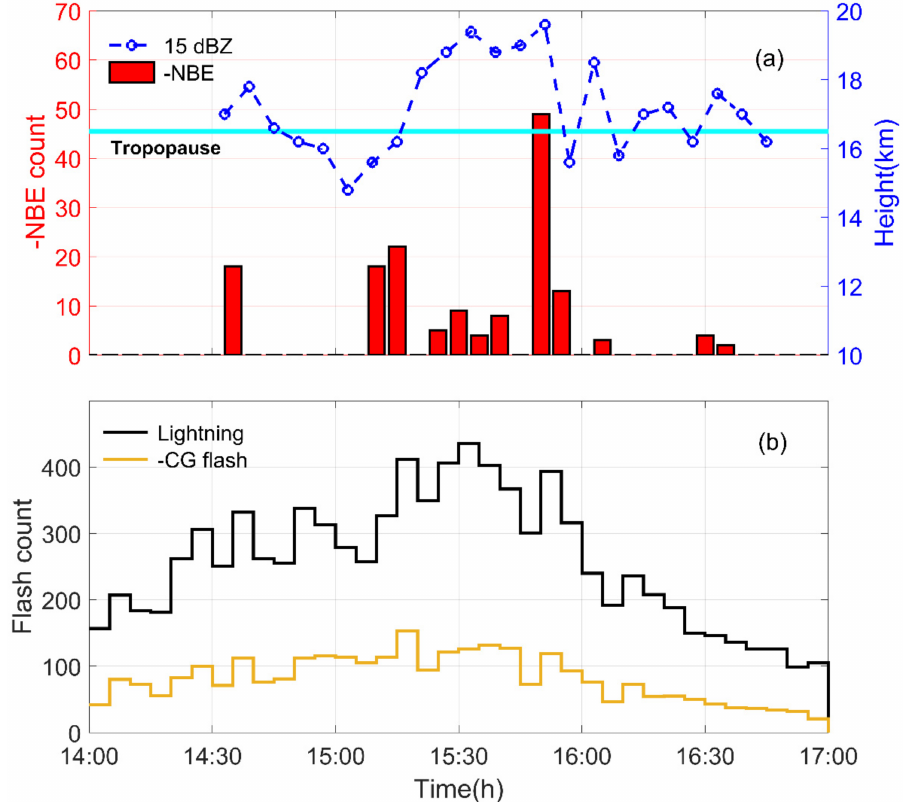
Figure 2. Variations in lightning activity and thundercloud top of the Hangzhou Bay Case. ( a ) The maximum height of 15 dBZ derived from the radar correlate with the outbreak of negative NBEs. The red histogram presents the negative NBEs in 5 min; the blue dashed line represents the maximum height of 15 dBZ derived from the radar, which was used to represent the thundercloud top; the cyan bold line represents the tropopause estimated from the sounding observations at Hangzhou station. ( b ) The normal lightning activity in the parent thunderstorm. The black histogram presents the lightning activity in 5 min while the dark yellow histogram presents negative CGs in 5